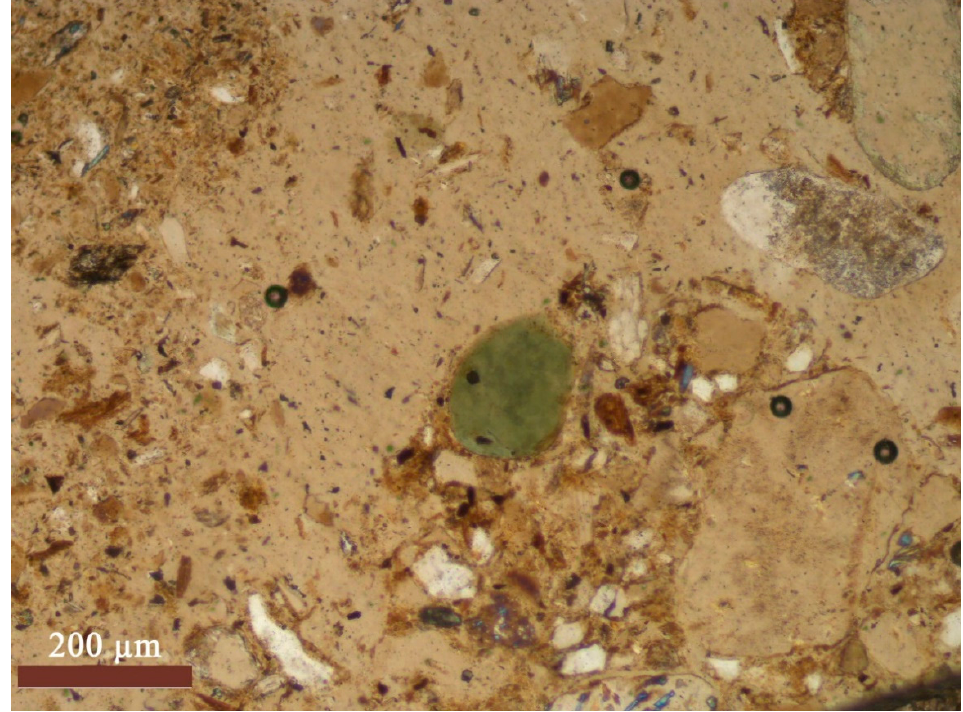
Figure 9. Glauconite, third terraces of Samoylov Island. (S 1 − 6). Plane polarized light.